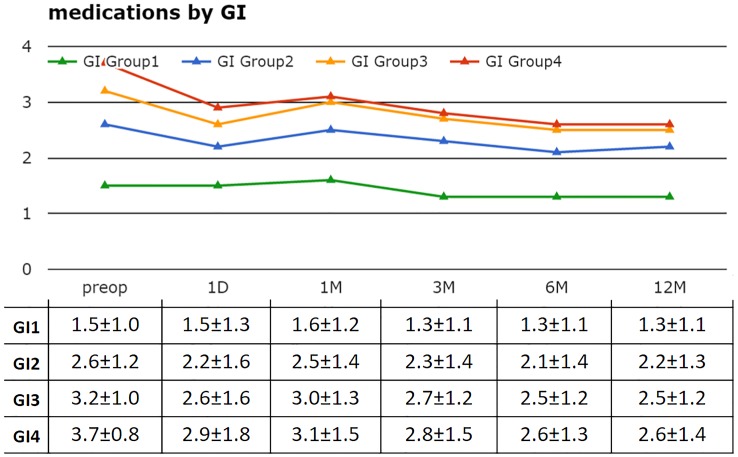
Mean number of medications by GI.While there was an overall decrease in the number of medications in all groups, GI3 and GI4 showed the most significant changes (p<0.05) after 6 months postoperatively.